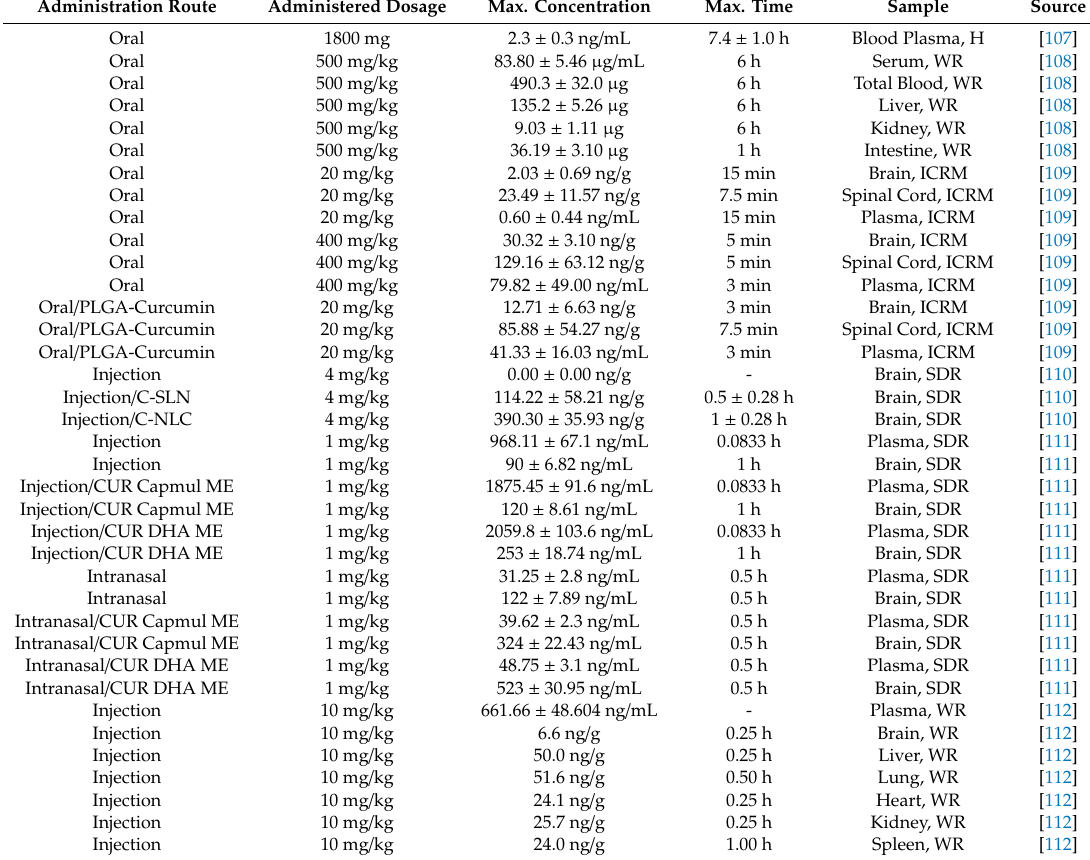
Table 3. Bioavailability of pure curcumin and various curcumin formulations after oral, intravenous, and intranasal delivery in humans, mice, and rats. Within the sample column, “H” refers to “humans”, “WR” to “Wistar rats”, “ICRM” to “ICR mice”, and “SDR” to “Sprague–Dawley